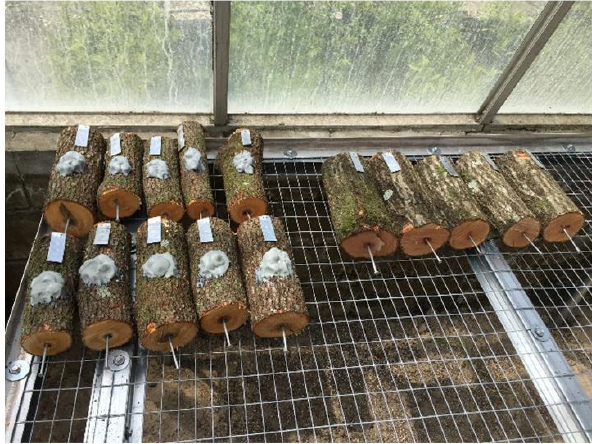
Figure 3. Freshly cut redbay bolts baited with SPLAT and non-baited controls used in the seminal repellent study in Hughes et al. (2017).